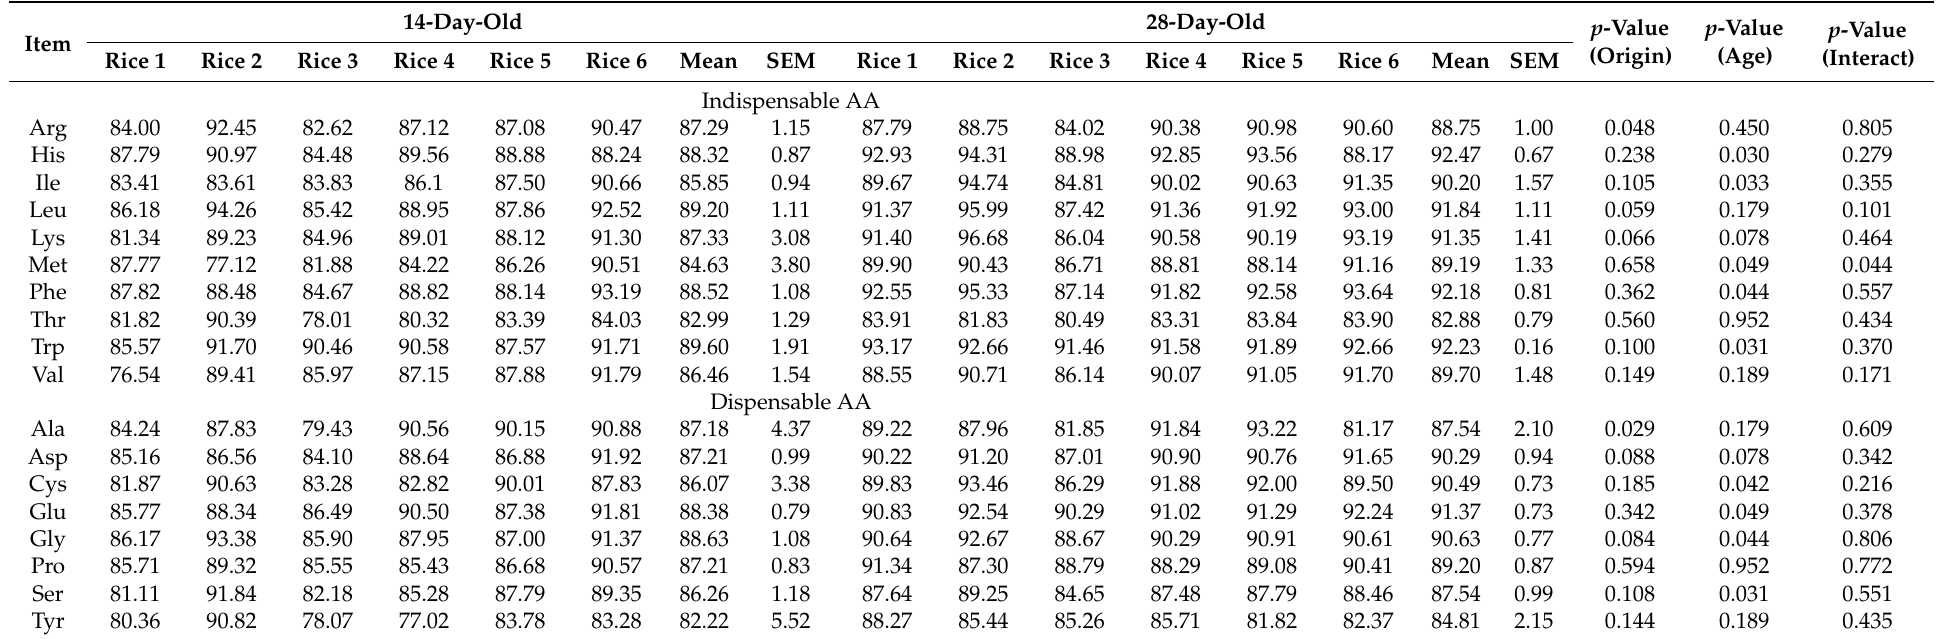
Table 7. Standardized amino acid digestibility of different sources rice in broilers (%).